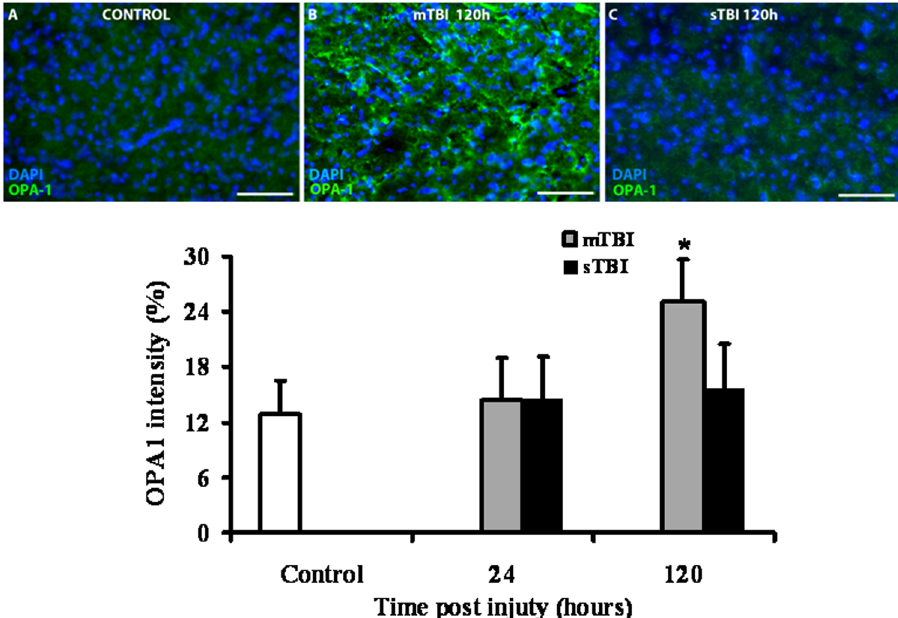
Figure 5. Immuno-staining with anti-OPA1 antibody of brain tissue of rats receiving TBI of graded severity (mTBI and sTBI) at 24 and 120 hours post-impact. In Panels A, B and C, representative staining of control, mTBI and sTBI rats, respectively, are illustrated. In the bar graph, mean values of immuno-staining with anti- OPA1 antibody are shown. Values of histograms are the mean of 6 animals. Standard deviations are represented by vertical bars. * Significantly different from controls, p < 0.05.